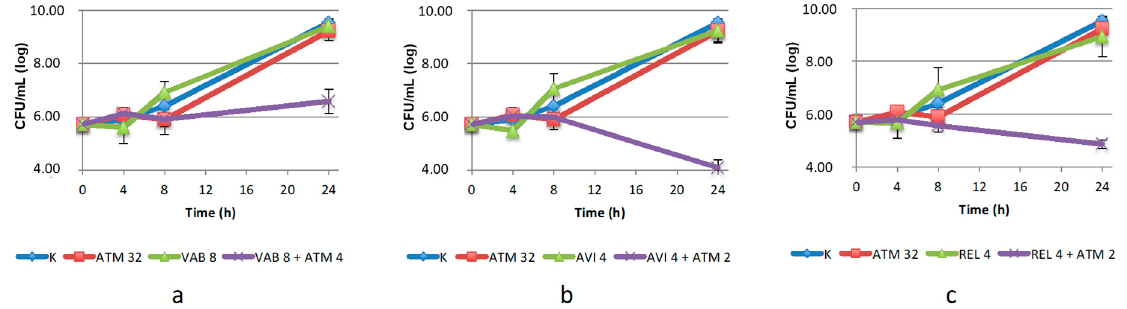
Figure 4. Twenty-four-hour time–kill curves of aztreonam (ATM) and: ( a ) vaborbactam (VAB); ( b ) avibactam (AVI); Figure 4 ( c ) relebactam (REL), alone and in combination, against the S. maltophilia isolate. K: positive control (without the addition of antimicrobials). Mean values and standard deviation of three independent experiments are